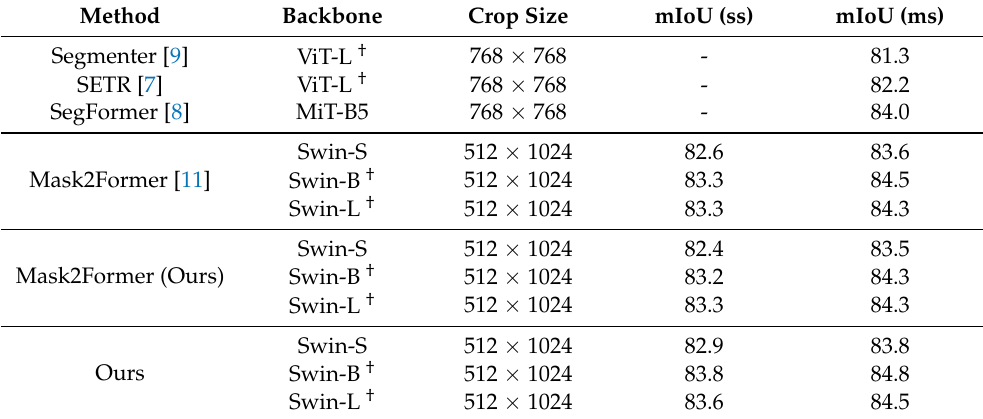
Table 5. Performance comparison of semantic segmentation on the Cityscapes validation dataset with 19 categories. †: backbone pretrained on ImageNet-22K. ss: single-scale. ms: